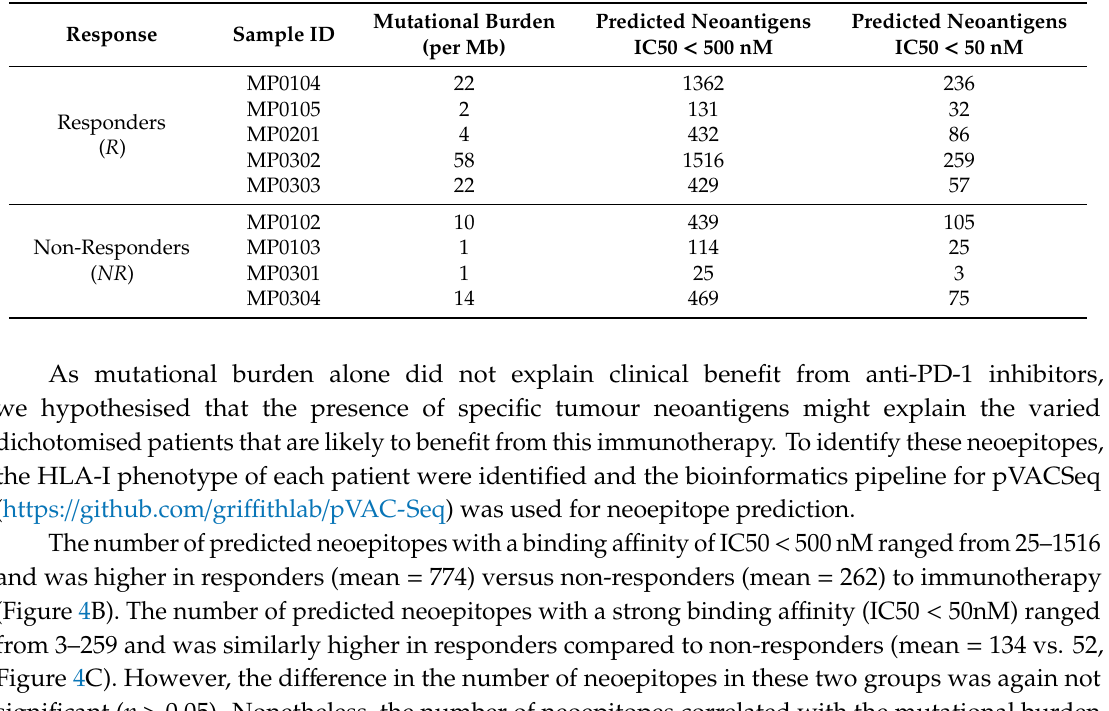
Table 1. Mutational burden and predicted neoepitope load of nine melanoma